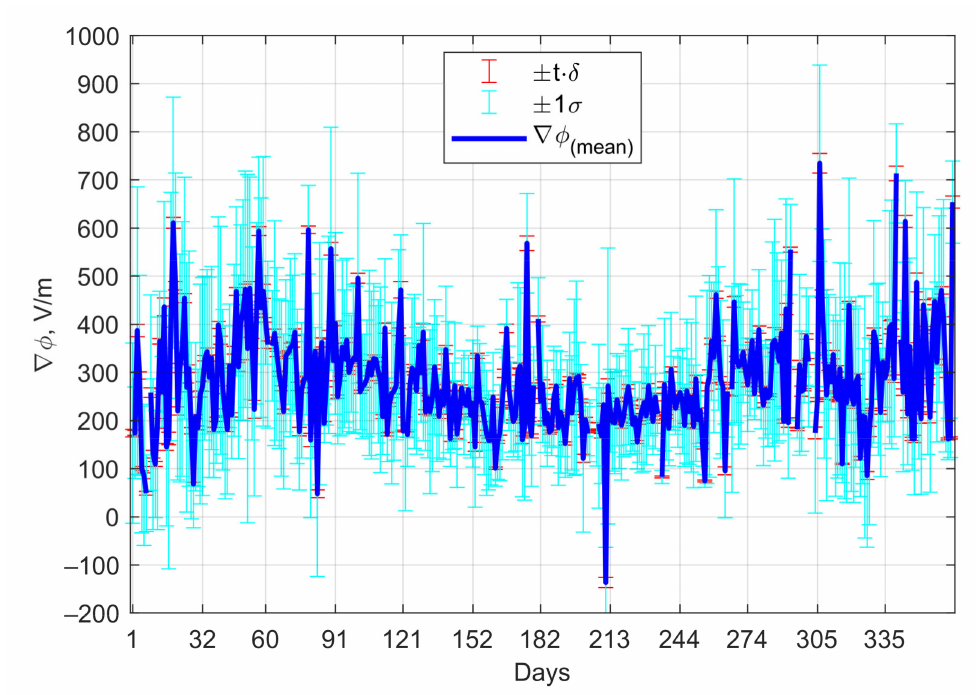
Figure 6. Hourly mean diurnal variation in the potential gradient under fair-weather conditions in Tomsk, calculated over 2006–2020. In the figure, the width of the confidence interval ± t · δ is determined by the multiplication of the Student’s t -value ( t ) and the standard error of the mean √ ( δ = σ / N, where σ —standard deviation, N—sample length), and ± 1 σ —the range equal to one standard